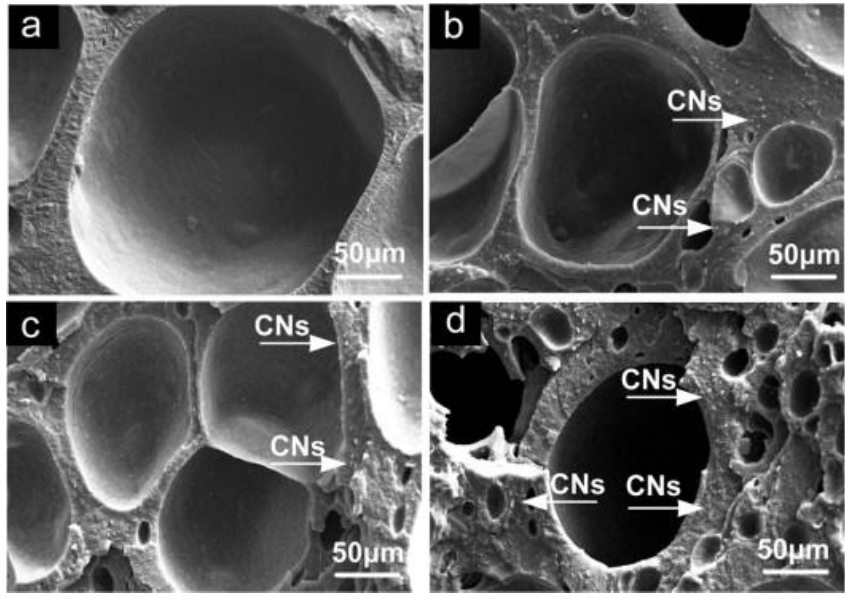
Figure 5. SEM images fractured surface of NBR/CNs nanocomposites ( a ) 3phr CNs, ( b ) 5 phr CNs, ( c ) 10 phr CNs and ( d ) 15 phr CNs [61].